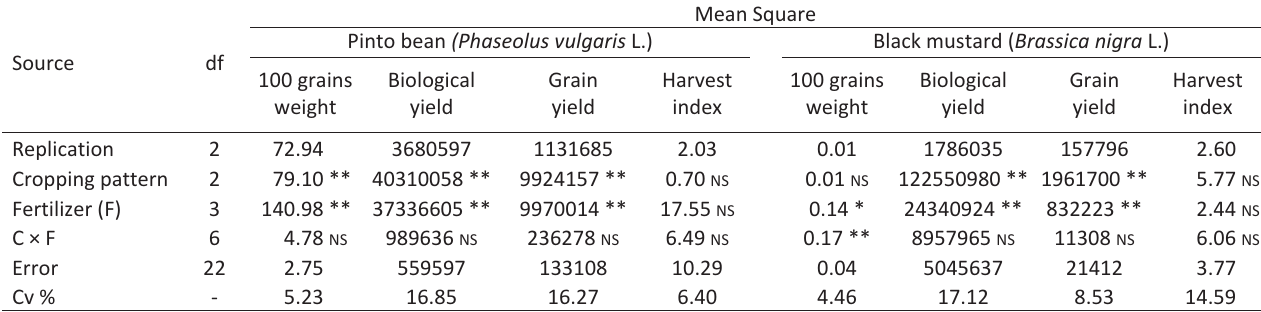
Table 2 ­ Analysis of variance of the agronomic traits in pinto bean and black mustard under different cropping patterns and fertilizer